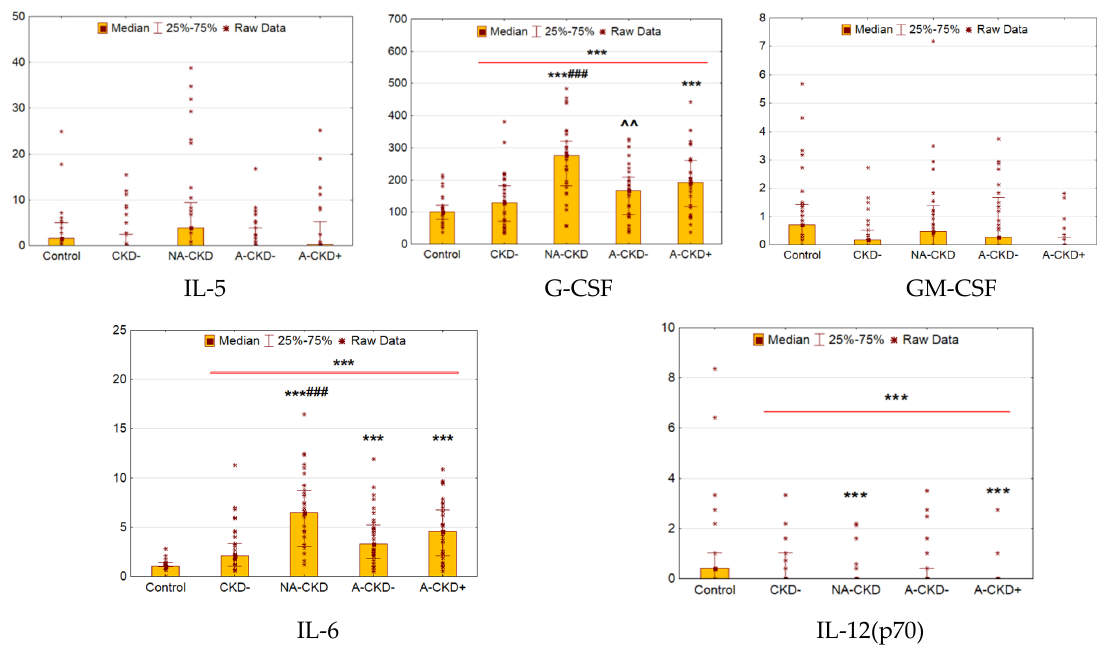
Figure 3. Serum concentrations of cytokines of IL-5, GM-CSF, G-CSF, IL-6, and IL-12 (pg / mL). CKD − : The group of individuals with estimated glomerular filtration rate (eGFR) ≥ 60 mL / min / 1.73 m 2 and urinary albumin-to-creatinine ratio (UACR) < 3.0 mg / mmol; NA-CKD: Non-albuminuric chronic kidney disease, the group of individuals with eGFR < 60 mL / min / 1.73 m 2 and UACR < 3.0 mg / mmol; A-CKD − : Group of patients with eGFR ≥ 60 mL / min / 1.73 m 2 and UACR ≥ 3.0 mg / mmol; A-CKD + : Group of individuals with eGFR < 60 mL / min / 1.73 m 2 and UACR ≥ 3.0 mg / mmol. *** p < 0.001 vs. non-diabetic control, ### p < 0.001 vs. CKD − ; ˆˆ p < 0.01 vs. NA-CKD; Mann–Whitney and Kruskal–Wallis test, Holm’s step-down